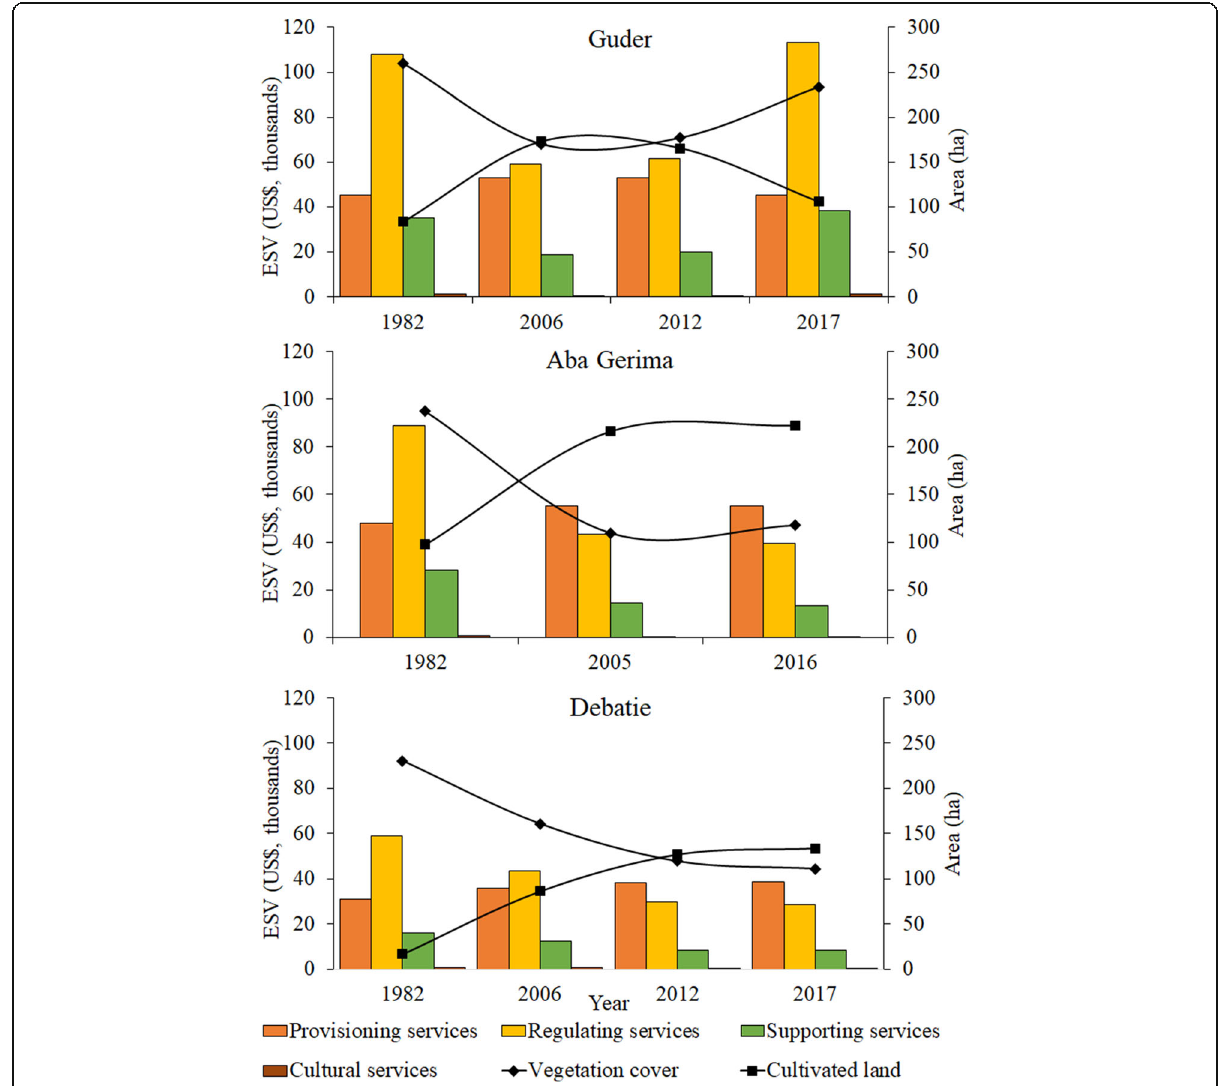
Fig. 5 Changes in four main ecosystem services values (ESVs) along with the area of vegetation cover and cultivated land from 1982 to 2017 in Guder, Aba Gerima, and Debatie watersheds,